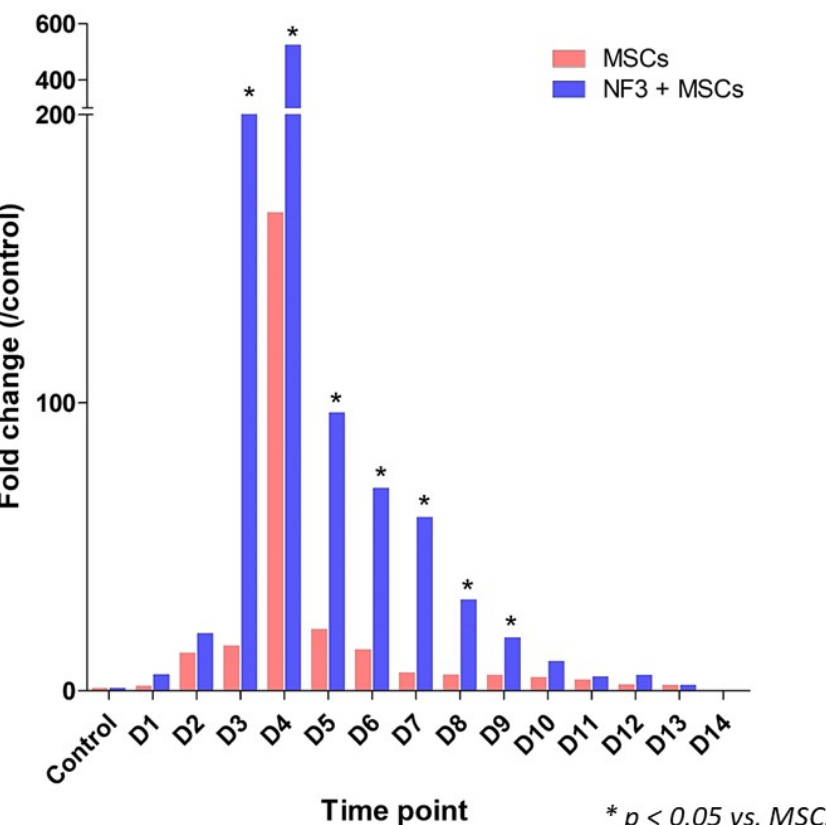
Figure 3. The expression of GFP in skin examined by RT-PCR. After GFP-MSC injection, the skin was harvested daily for analysis. The peak level of expression presented on Day 4 in both groups. It dropped gradually from Day 5 and diminished on Day 14. Compared with the MSCs group, a significant increase in the GFP expression was observed in the combined group from Day 3 to Day 9. No GFP expression was detected on Day